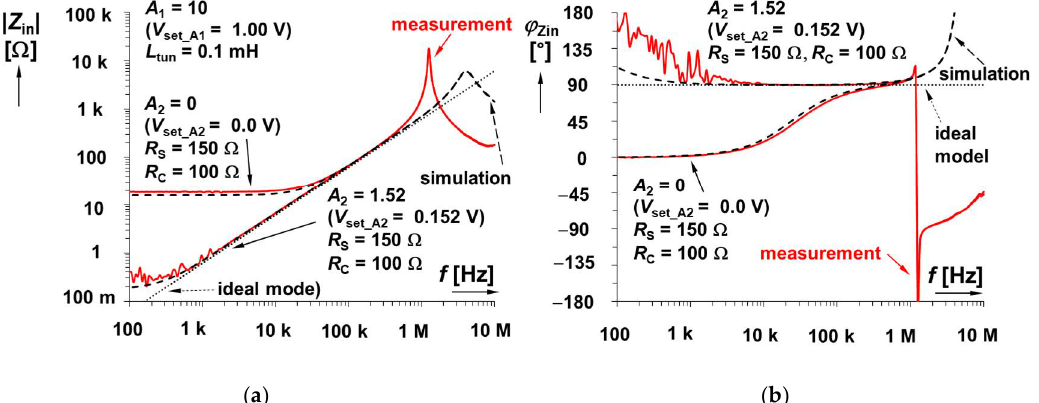
Figure 7. Comparison of lossless and lossy impedance plots for fully electronically adjustable solution in Figure 3: ( a ) magnitudes and ( b ) phases.